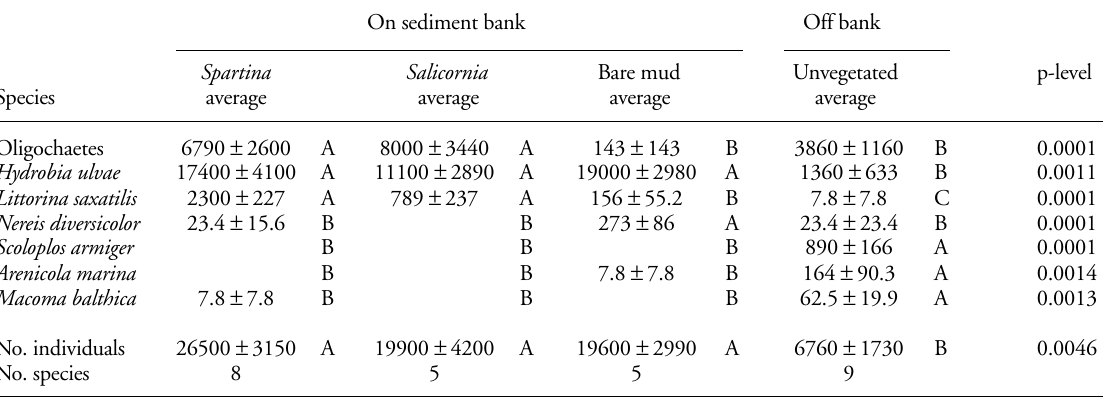
Table 1. Mean densities of selected species m –2 , mean total numbers of individuals m –2 and total numbers of species in each habitat (with SE) (not all species found are presented). Results of a 1-way ANOVA evaluating effect of habitat are also presented with Student- Newman-Keuls multiple ranges. Means with the same letter are not significantly